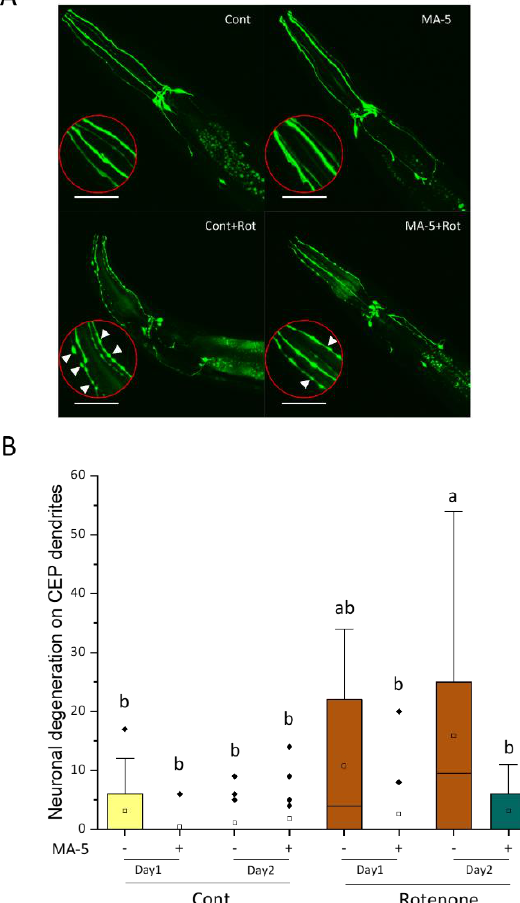
Figure 6. MA-5 suppresses rotenone-induced neurodegeneration in dopaminergic cephalic (CEP) neurons. Transgenic C. elegans. TG2435 ( vtIs1 [ dat-1p::GFP + rol-6(su1006) ] V) expressing dopaminergic neurons tagged with a green fluorescent protein (GFP) following rotenone treatment with or without MA-5 were monitored after 24 and 48 h. ( A ) Representative images of dopamine neuron degeneration under different treatments for 48 h. (Scale bar: 50 µm). White arrowheads in the enlarged red circles indicate neuronal processes that exhibit abnormally discontinuous GFP signals. ( B ) Frequency of the four CEP blebs along the dendrites in animals ( n = 18 – 20/treatment). Data are shown as box plots to indicate median (central line) and mean (square mark). Different letters indicate significant differences ( p ≤ 0.05) using one-way ANOVA and Tukey ’ s HSD test with all data points including outliers. Cont: control treated with 0.1% of DMSO; MA- 5: 10 μM; Rot: 2 μM rotenone; Diamond mark: outlier data.